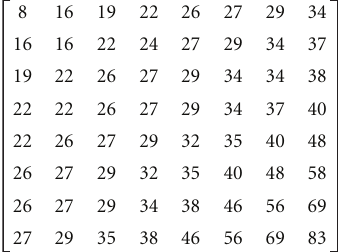
Figure 2: Intra quantization matrix for VC-1 and MPEG-2/4.